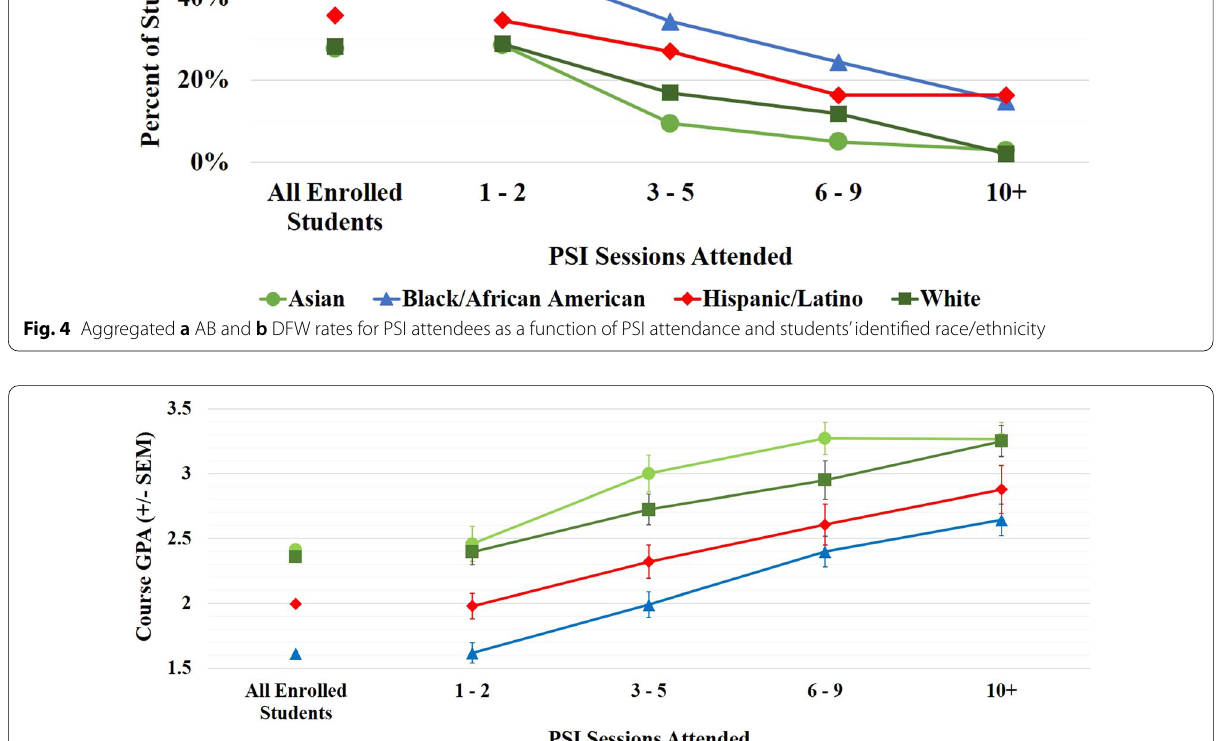
1789) as a function of PSI attendance, and of all students enrolled in PSI‑supported courses =